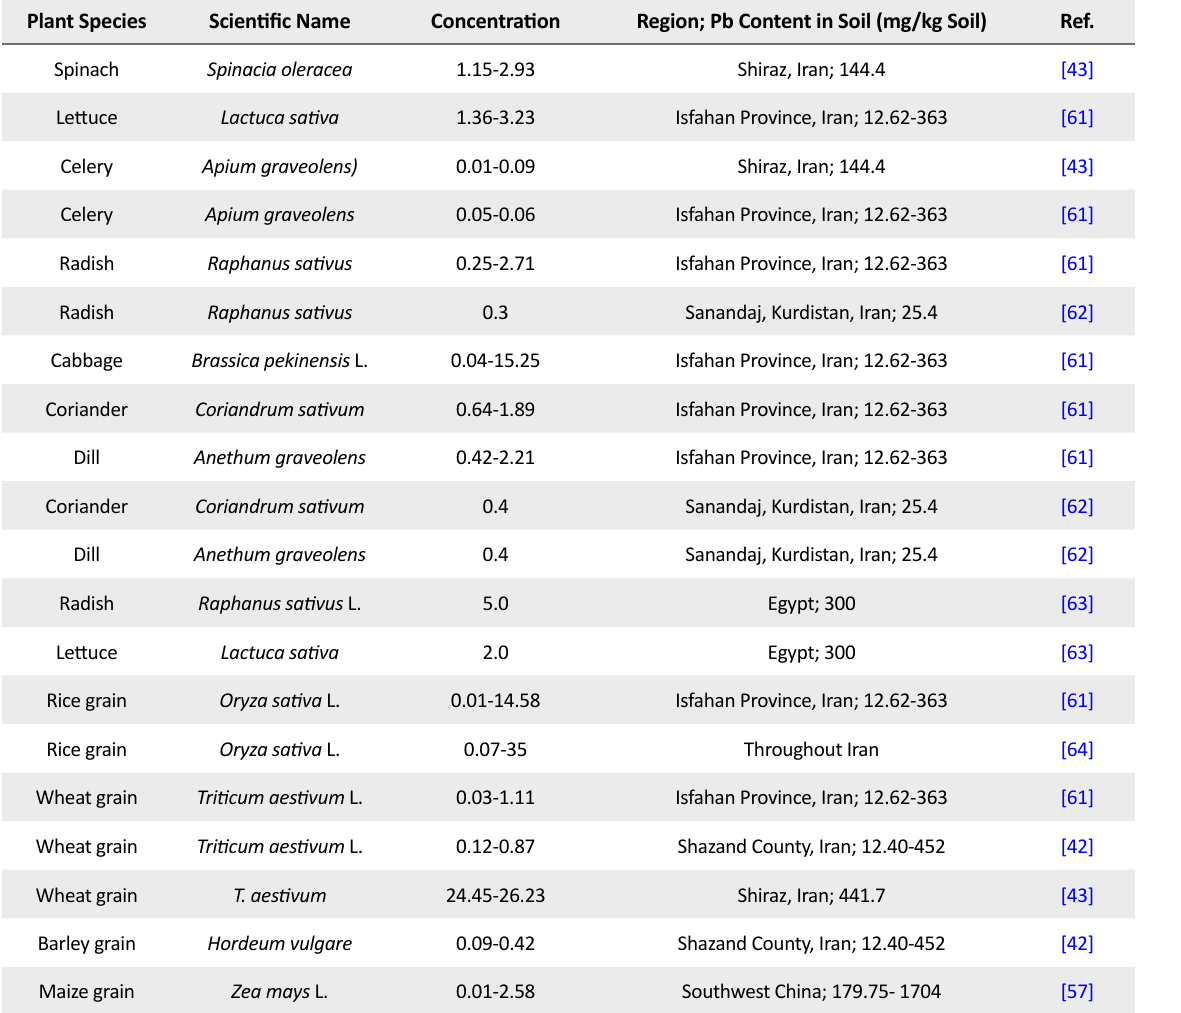
Table 3. Lead (Pb) concentration (mg/kg dry weight) in some crops Plant